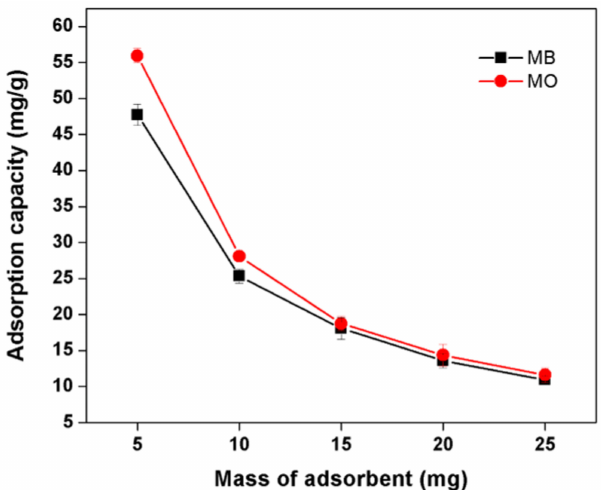
Figure 7. Effect of adsorbent dosage on the adsorption of MB and MO dyes onto the Kg-Ch sponge ( C 0 = 20 Mg L − 1 ; contact time: 120 Min; pH = 8 for MB and 4 for MO; temperature: 25 ◦